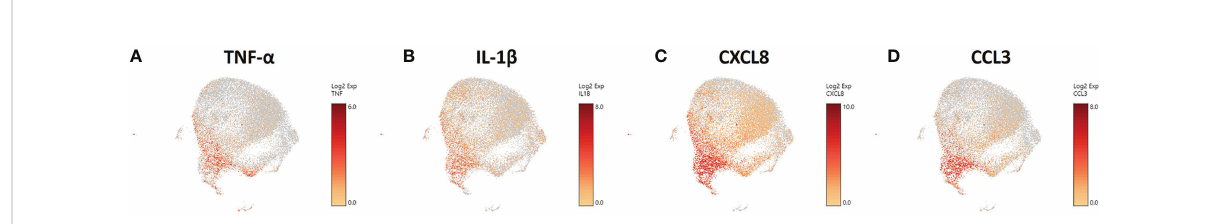
FIGURE 7 Phagocytic APCs Incubated with C. neoformans Are Differential in TNF- a and Genes Downstream of TNF- a . Processed human BAL cells were enriched for phagocytic APCs and incubated with C neoformans strain H99 for 2h and then processed for scRNA-seq. scRNA-seq